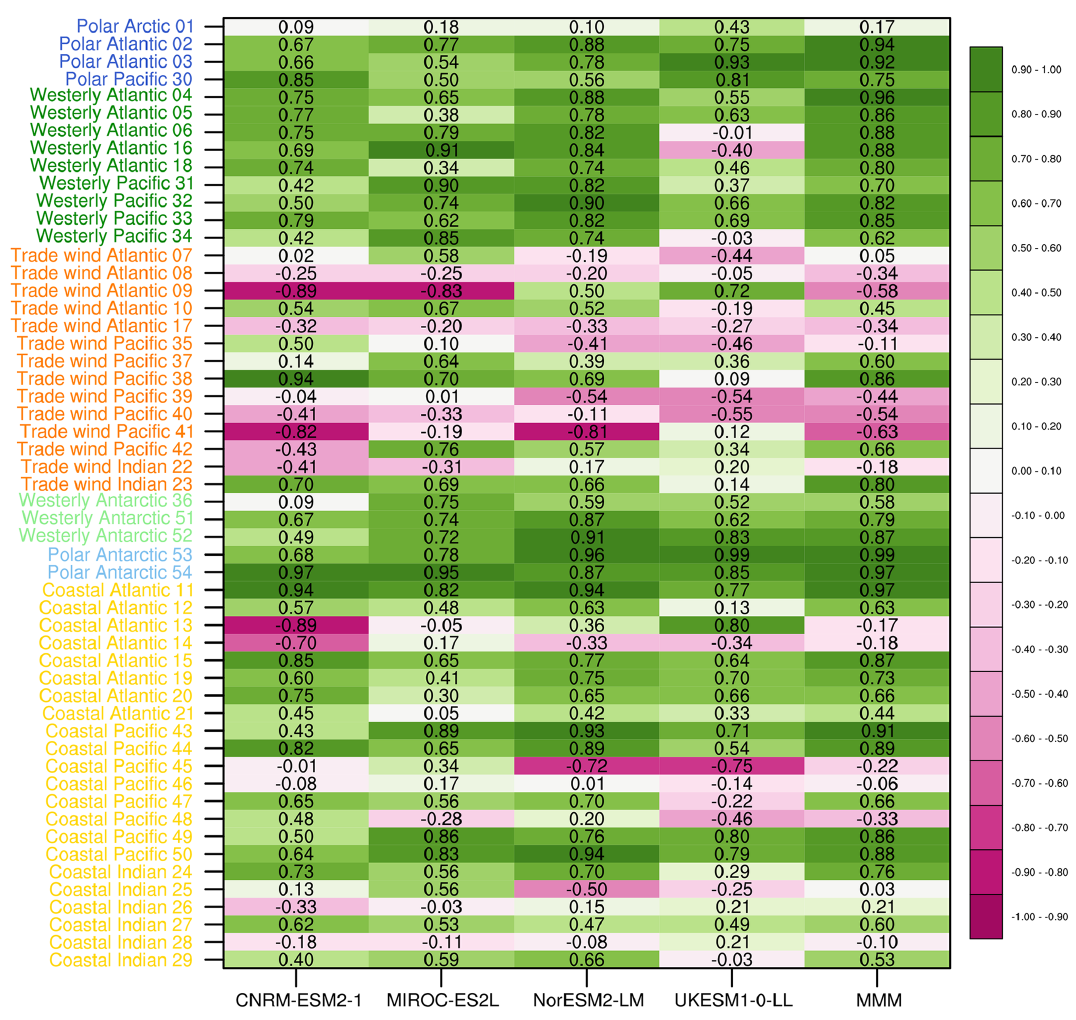
Table 5. Correlation coefficients of the linear regressions between the monthly time series of the models and L11. Time series and